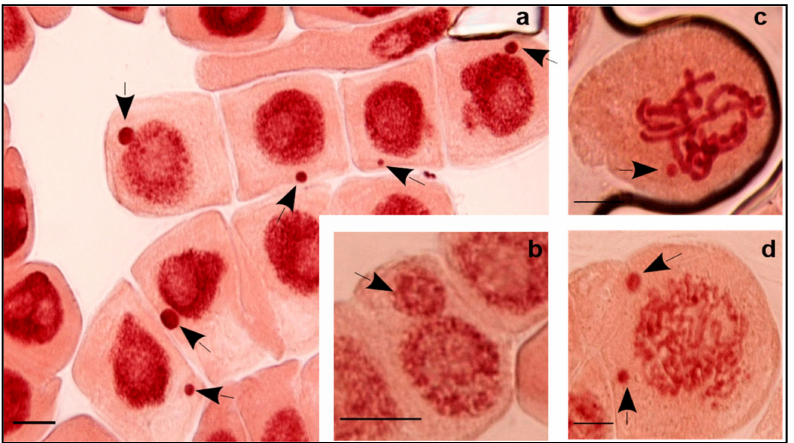
Figure 2. Vicia cells with different size and number of micronucleus (MCN) under exposure to C4 water samples. The size of a MCN was compared to the main nucleus. ( a ) Cells with a small or a medium MCN (EC = 4 dS m − 1 ); ( b ) Cell with a large MCN (EC = 6 dS m − 1 ); ( c ) Cell in division with a MCN (EC = 4 dS m − 1 ); ( d ) Cell in division with two MCNs (EC = 6 dS m − 1 ). Arrow indicates MCN. Magnification: 1000 × ; Bar = 20 µ